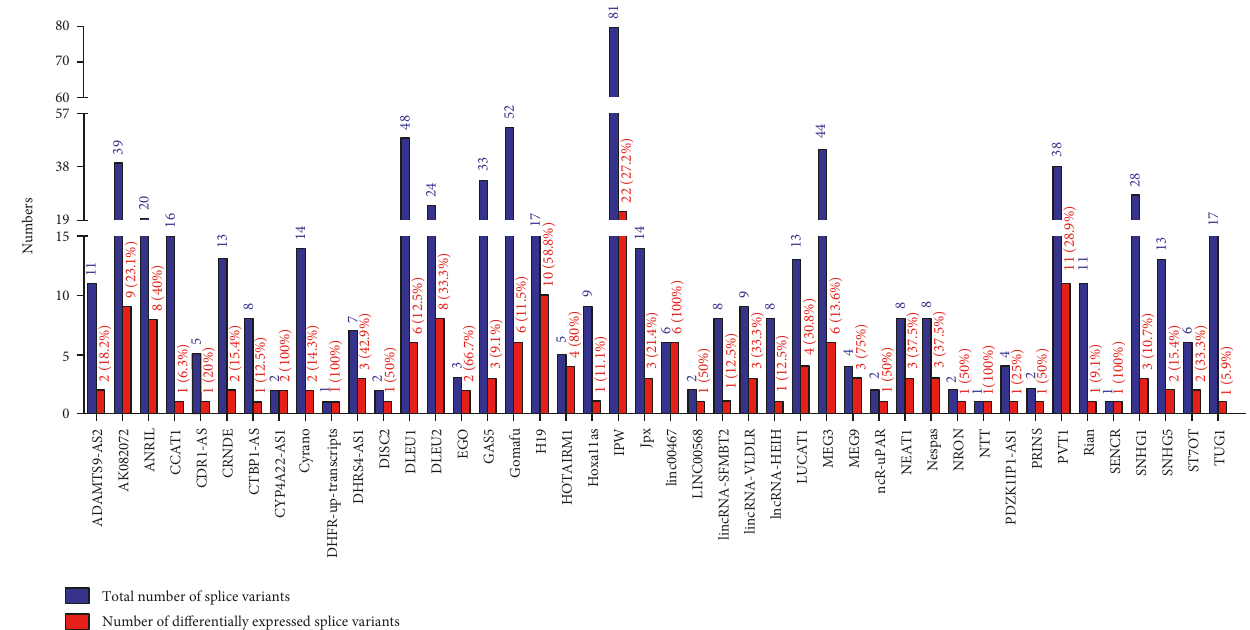
Figure 6: Bar diagram represents total splice variants available for 44 functionally annotated lncRNAs and their respective di ff erentially expressed splice variants in HMECs after LPS treatment.